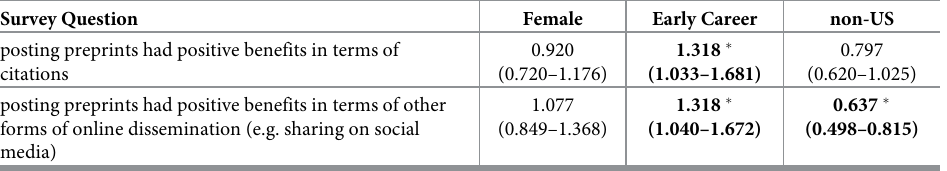
Table 3. Results of ordinal logistic regression for survey questions in Fig 6 (corresponding authorships only; N = 1146). Values are presented as exponentiated odds-ratios, with the range in parentheses representing 95% confi- dence intervals. Significant results at the 95% level are indicated in bold and with “ �